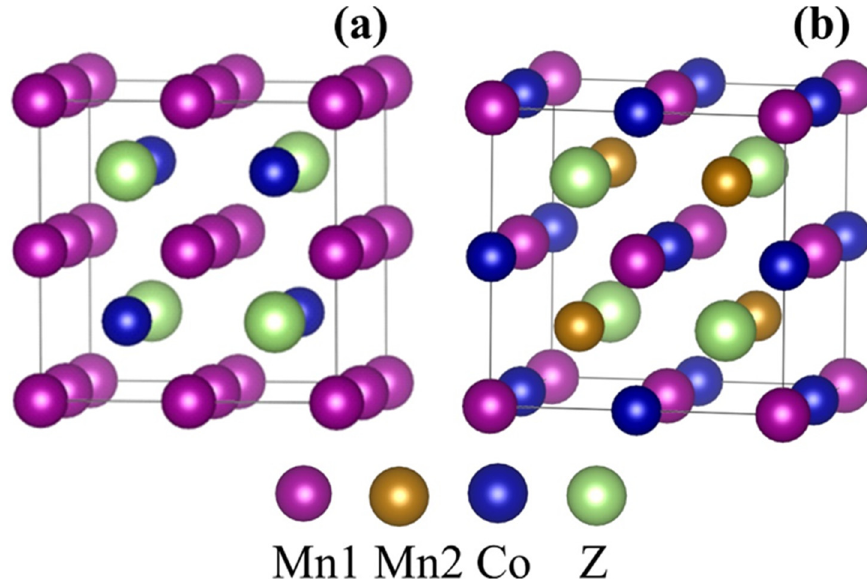
Figure 1. Unit cells of the Heusler alloys Mn 2 CoZ of structure ( a ) L 2 1 and ( b ) XA.